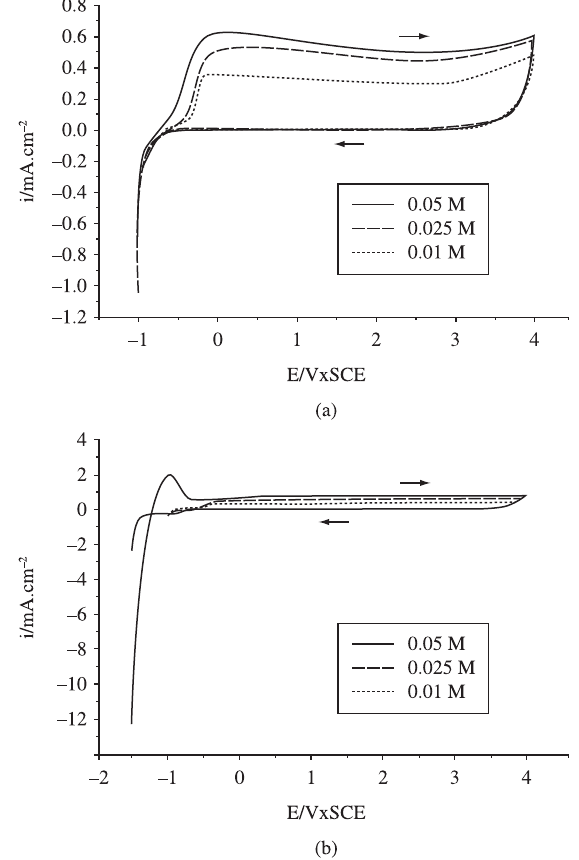
Figure 6. Voltammetric curves obtained in citrate buffer pH 4.0 containing 0.01 M , 0.025 M and 0.05 M NaF a) Ti grade 2; b)